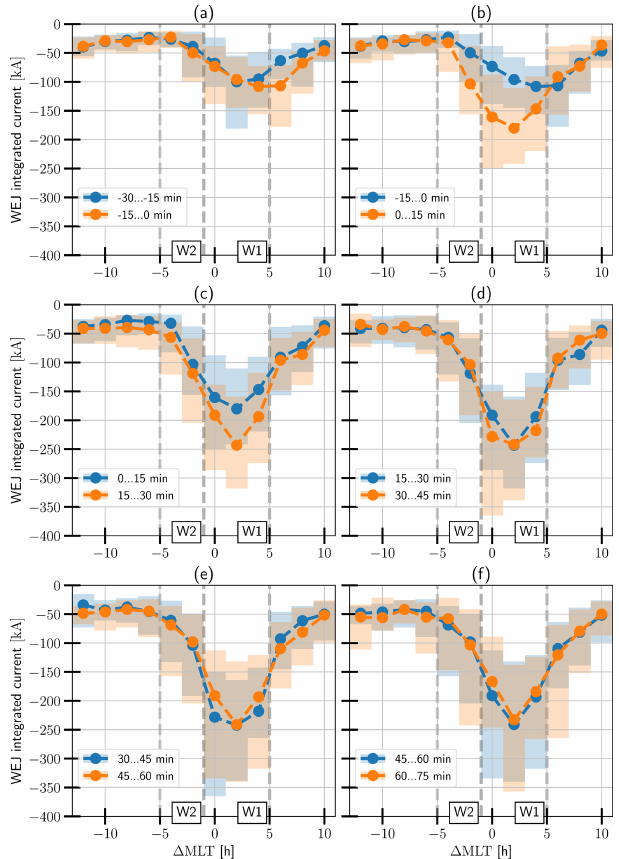
Figure 6. The evolution of the EEJ compared with the previous time step for the time period from 30min before to 75min after the onset. The lines show the medians, and 50% of the values are contained within the bars in each